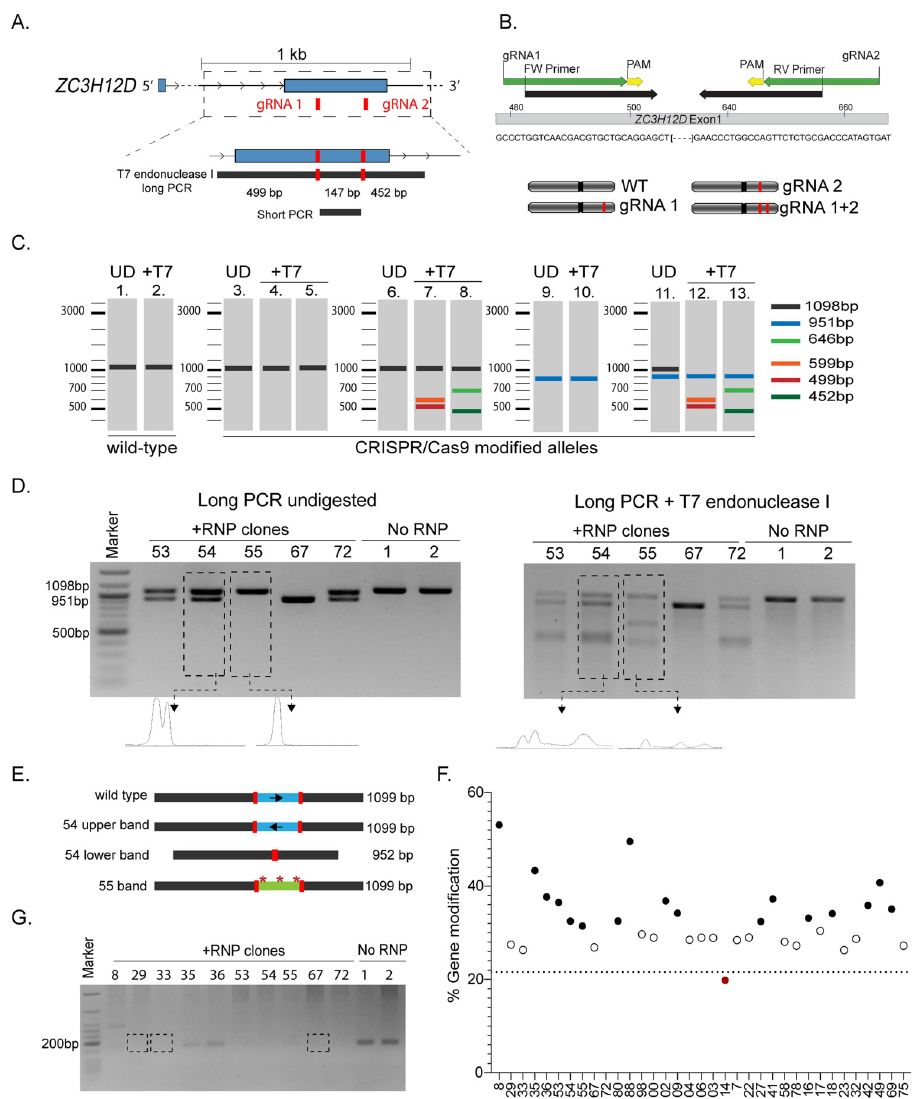
Fig 4. Deletion of the ZC3H12D gene in primary human T lymphocytes. (A) Schematic representation of the ZC3H12D gene with indicated the location of gRNAs and PCR products. (B) Top: location of the “short PCR” primers compared to the location of the gRNAs and the ZC3H12D genomic sequence. Bottom: RNP transfection may lead to alleles that are unmodified (WT), modified only at the location of one gRNA (gRNA 1 or 2), or modified at both locations (gRNA 1+2), leading to the possible alleles shown. In each cell, all combinations of any of these two alleles are also possible (red: gene modification). (C) Schematic representation of all the possible outcomes of the T7 endonuclease I cleavage assay performed on different combination of alleles as in (B) UD = undigested. (D) After transfection with RBPs targeting the ZC3H12D gene and cell cloning, individual T cell clones were expanded and the gDNA analyzed for the presence of indels/ mutations by T7 endonuclease I cleavage assay. The panels show the PCR product before (left) or after (right) digestion with the T7 endonuclease I enzyme. The density plots show representative quantifications (Representative clones from two independent donors) No RNP = mock transected control clones. (E) Schematic representation of the Sanger sequencing results of the PCR bands for clones 54 and 55 shown in panel (D) . (F) Percentage of gene modification of clones analyzed as in (D) (n = 35 clones). (G) Short PCR to assess the presence of DNA deletions between the two gRNAs (n = 12 clones from two independent donors). alleles and alleles modified by either gRNA 1 or 2 will be present in the population, and this will give rise to a combination of uncleaved and cleaved products ranging from 455 bp to 643 bp ( Fig 4C , lanes 7 and 8). Finally, if both gRNA 1 and 2 lead to the deletion of the intervening